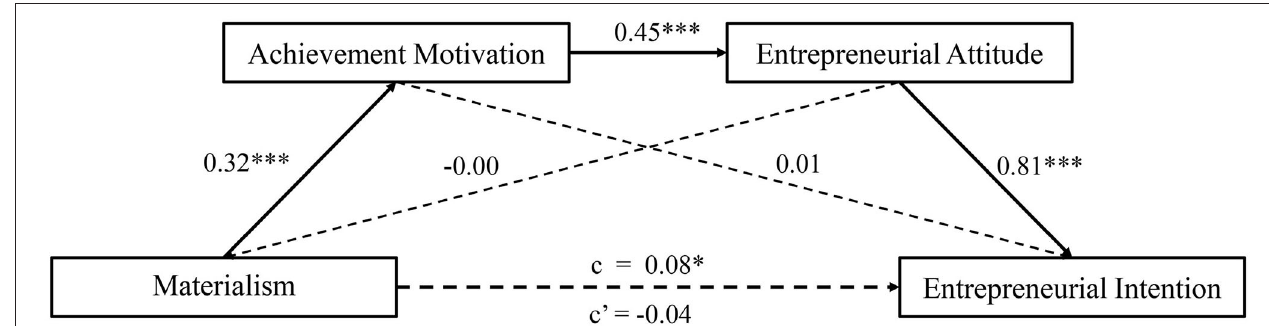
FIGURE 2 | The serial mediation model without control variables. Path coefficients are standardized estimates. [c] represents the total effect, [c ′ ] represents the direct effect. * p < 0.05; *** p <